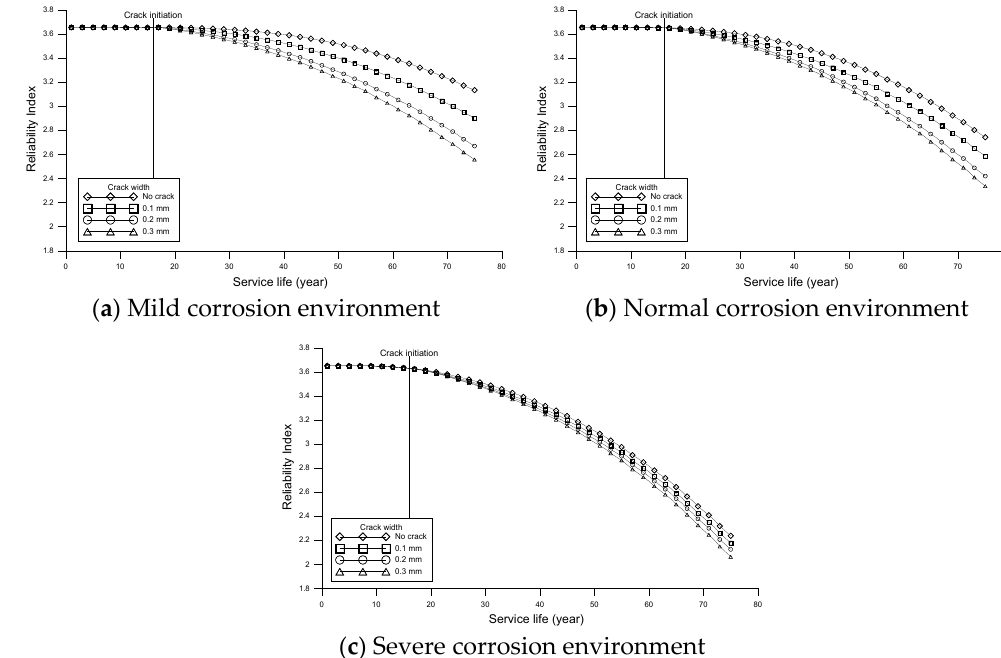
Figure 14. Reliability degradation considering crack width under light traffic characteristics (calibrated model (1-W)).